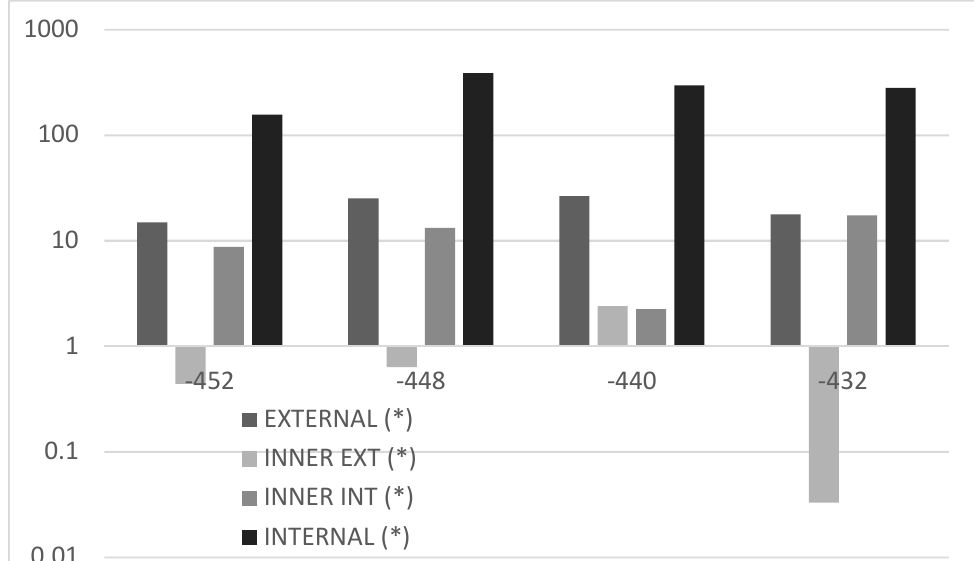
Figure 30. Strain difference between the signal taken by the optical fiber for a certain position of the flaw, and the deformation resulting when the imperfection is placed at the middle of the cap. Focus in the region of the damage. In the small picture embedded, there is an enlarged image of this ref- erenced signal. Values are referenced to those recorded in the case of a flaw placed at the middle of the cap (*).